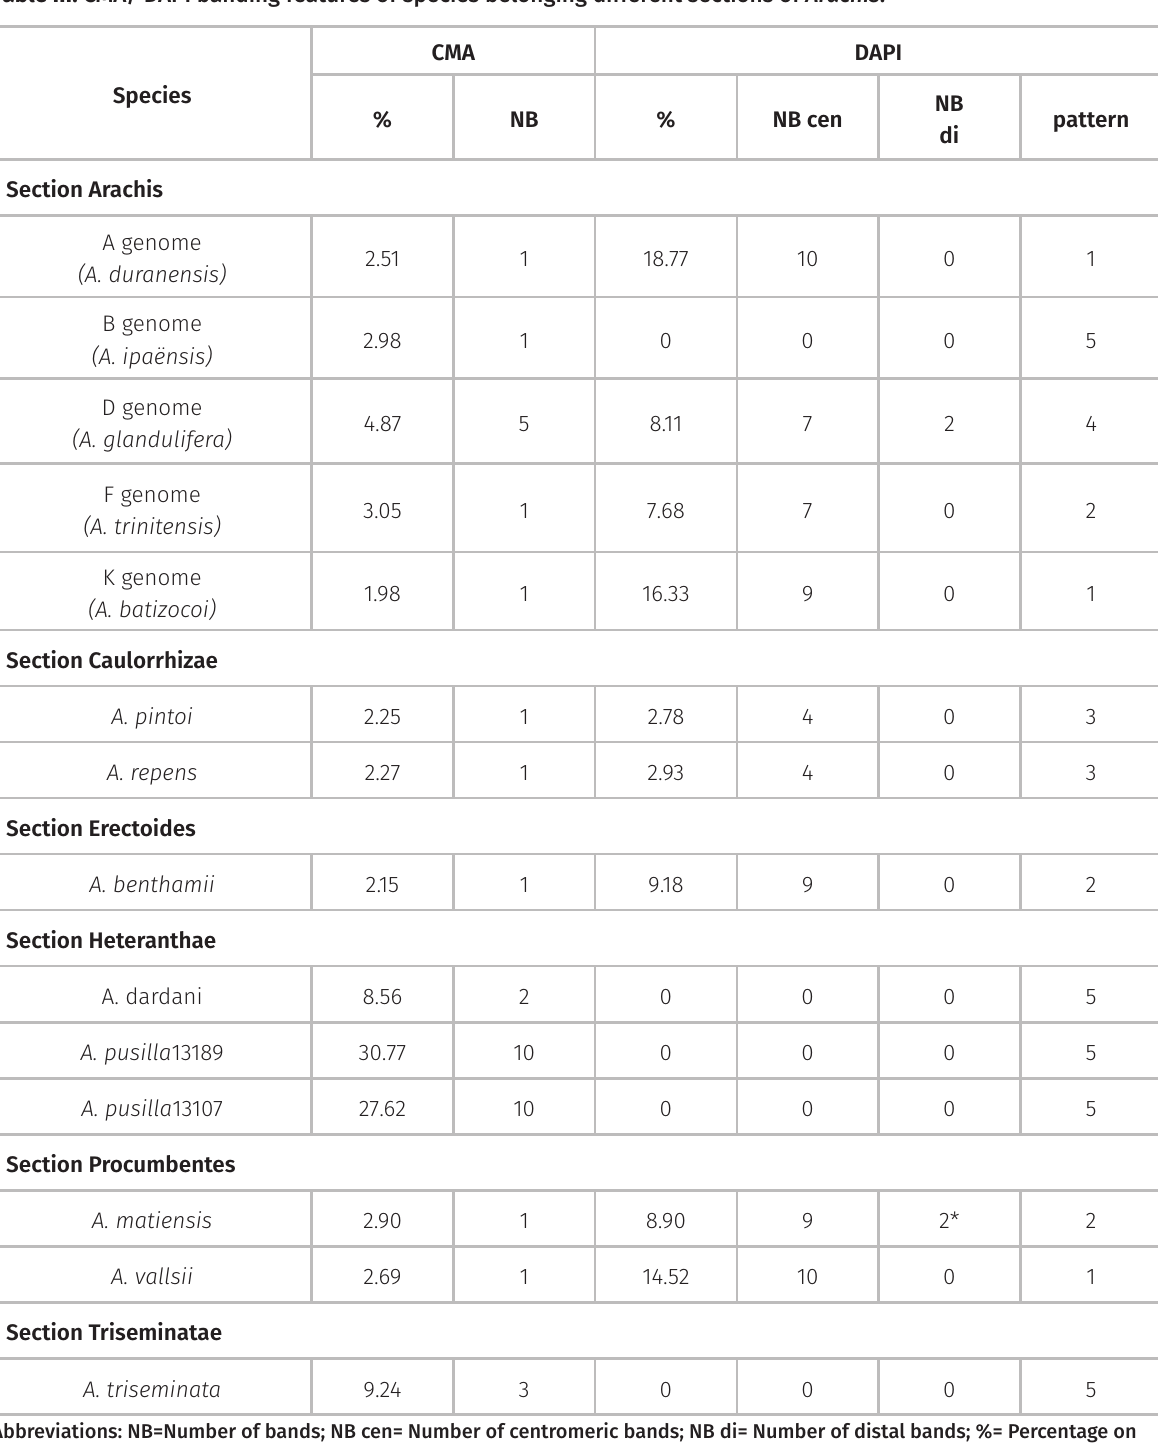
Table III. CMA/ DAPI banding features of species belonging different sections of Arachis . CMA DAPI Species % NB